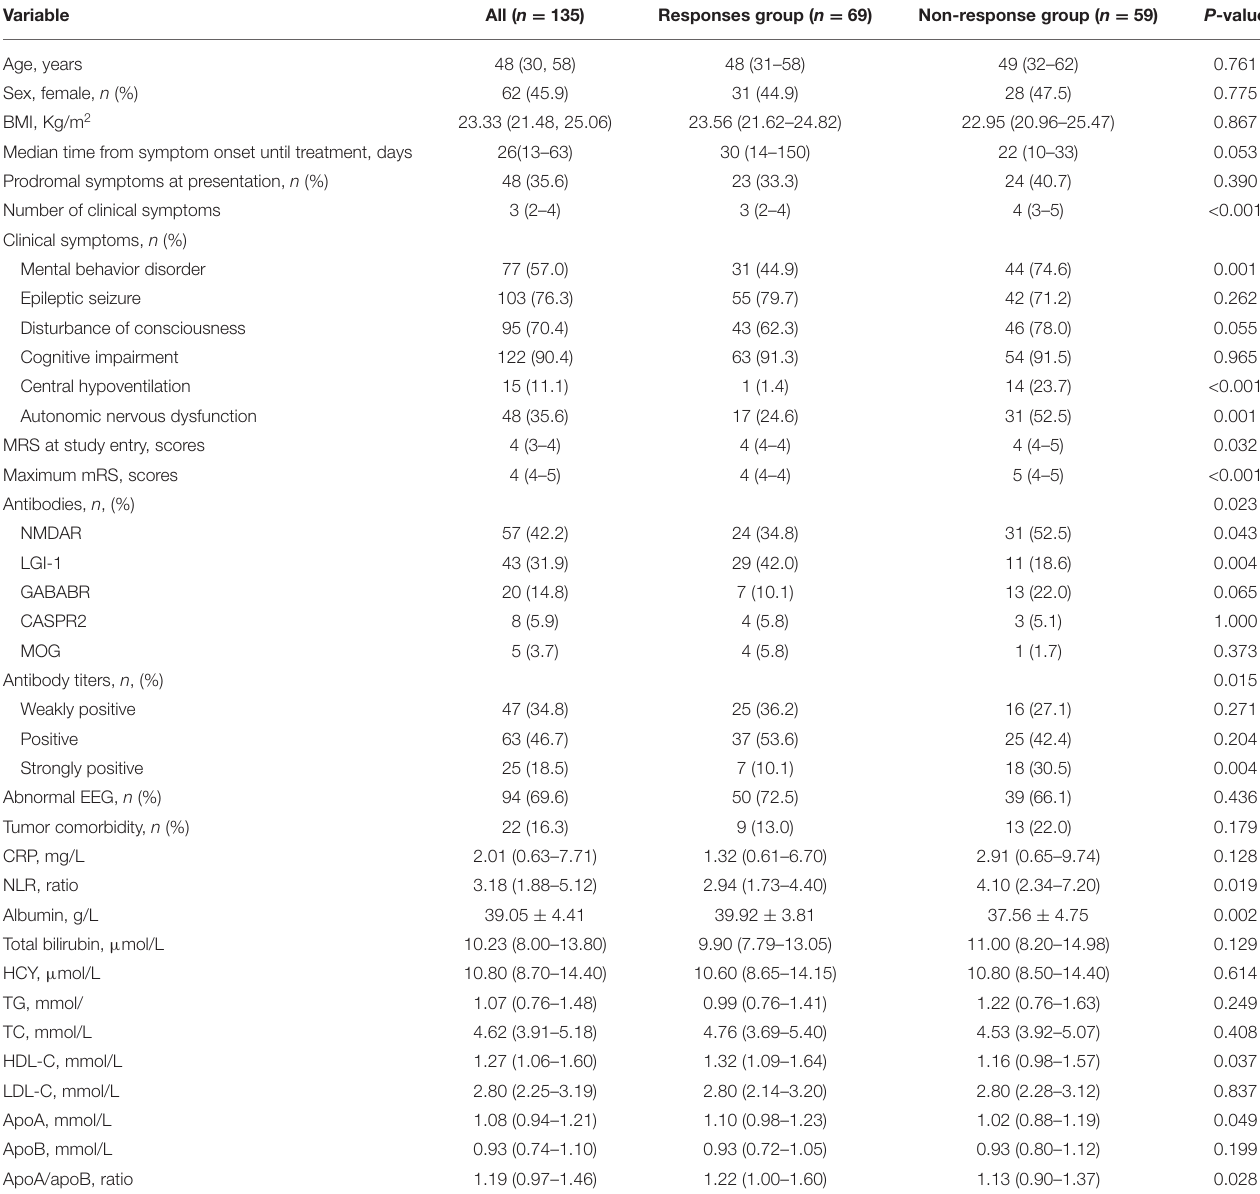
TABLE 1 | Demographic and clinical characteristics of patients with autoimmune